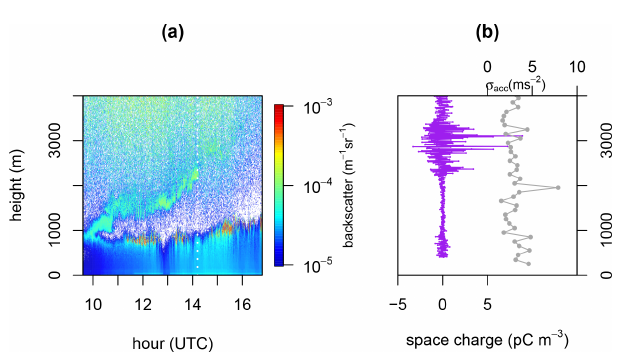
Figure 15. Dust cloud over Reading, 16 October 2017, sampled by an instrumented radiosonde released at 14:12UTC. (a) Ceilome- ter backscatter profiles around the time of the sounding, with bro- ken cloud around 1000m through which some dust fall occurred. (b) Charge profile (lines) determined by the balloon electrometer and the standard deviation of the vertical acceleration (lines and dots) encountered by the balloon package, calculated in vertical steps of 100m. (Adapted from Harrison et al.,